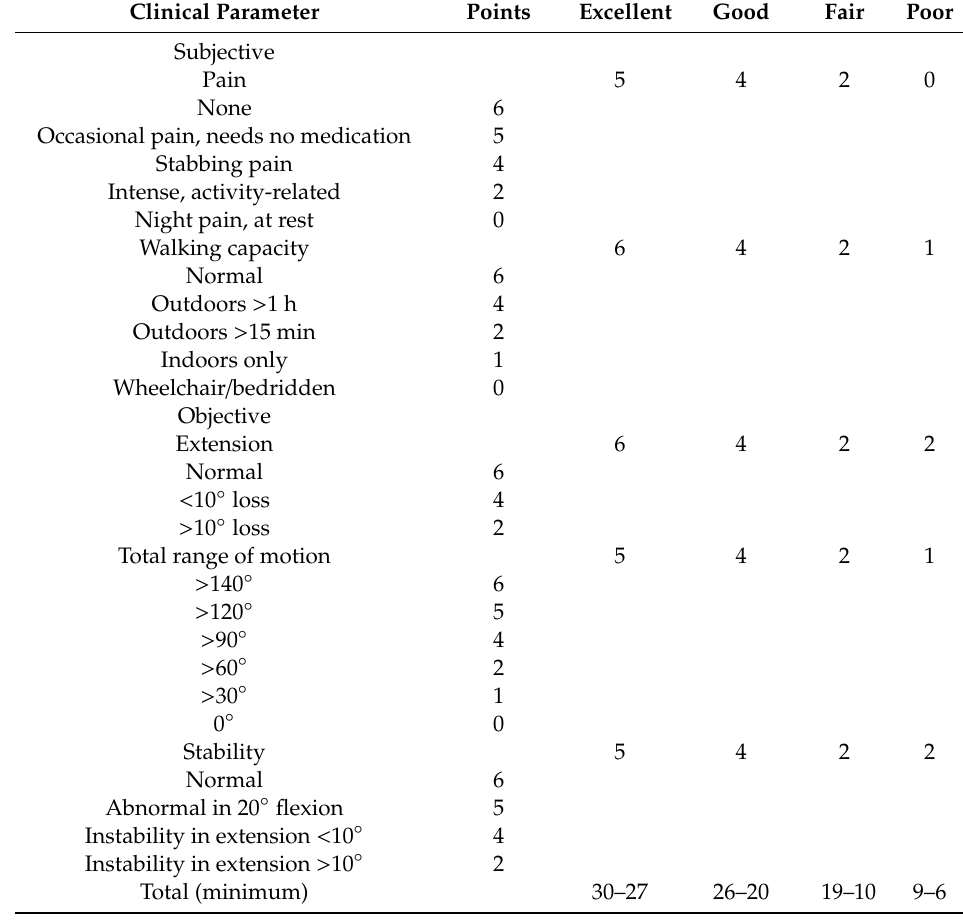
Table 2. Criteria for clinical